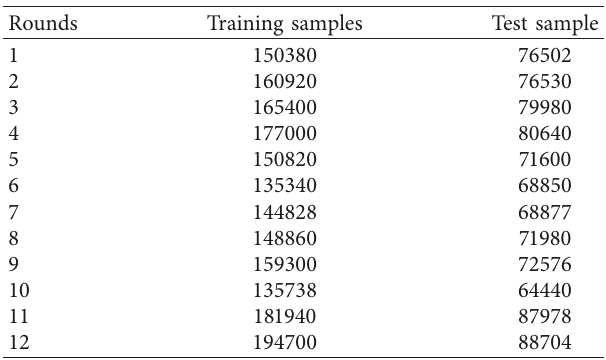
Figure 4: Visual distributions of the breast mass features: (a) original underlying features; (b) network layer features; (c) features learned by the proposed method. Table 3: Samples for each